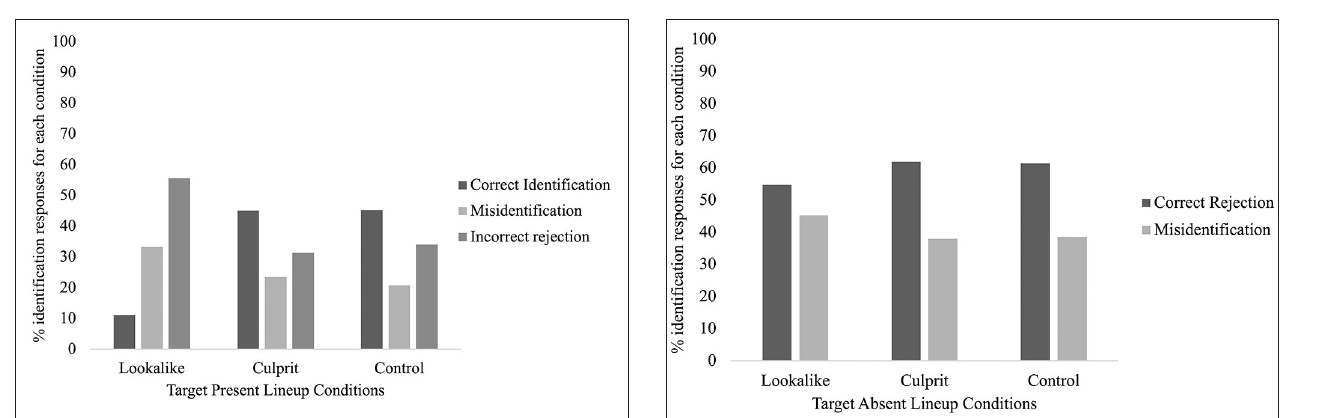
FIGURE 2 | The proportion of identification responses (correct rejections, and misidentifications) for the target absent lineup conditions (culprit, lookalike, and control).